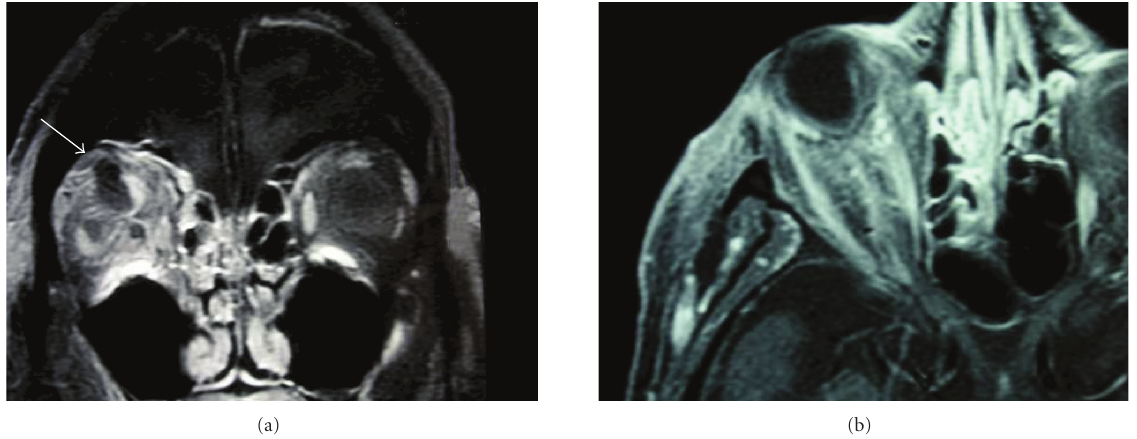
Figure 2: Cephalic and orbital MRI. (a) The arrow shows a hyposignal corresponding to the abscess, (b) exophthalmos stage